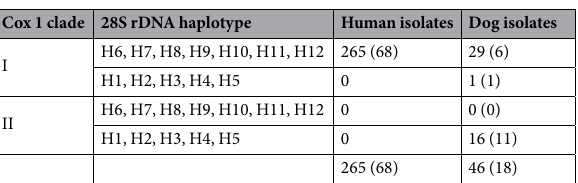
Table 4. 28S rDNA haplotypes identified in humans and dogs. 28S haplotypes were grouped into 2 categories (H1–H5 or H6–H12) based on the phylogenetic analysis (Fig. 3). Numbers outside the brackets indicate the number of nematodes that belong to each category. Numbers inside the brackets indicate the number of hosts from which worms belonging to the respective categories were isolated.